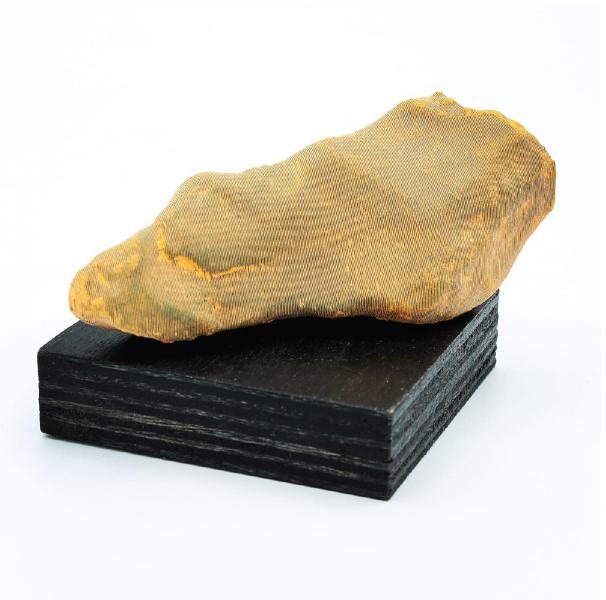
Figure 16: Uncanny pandemic